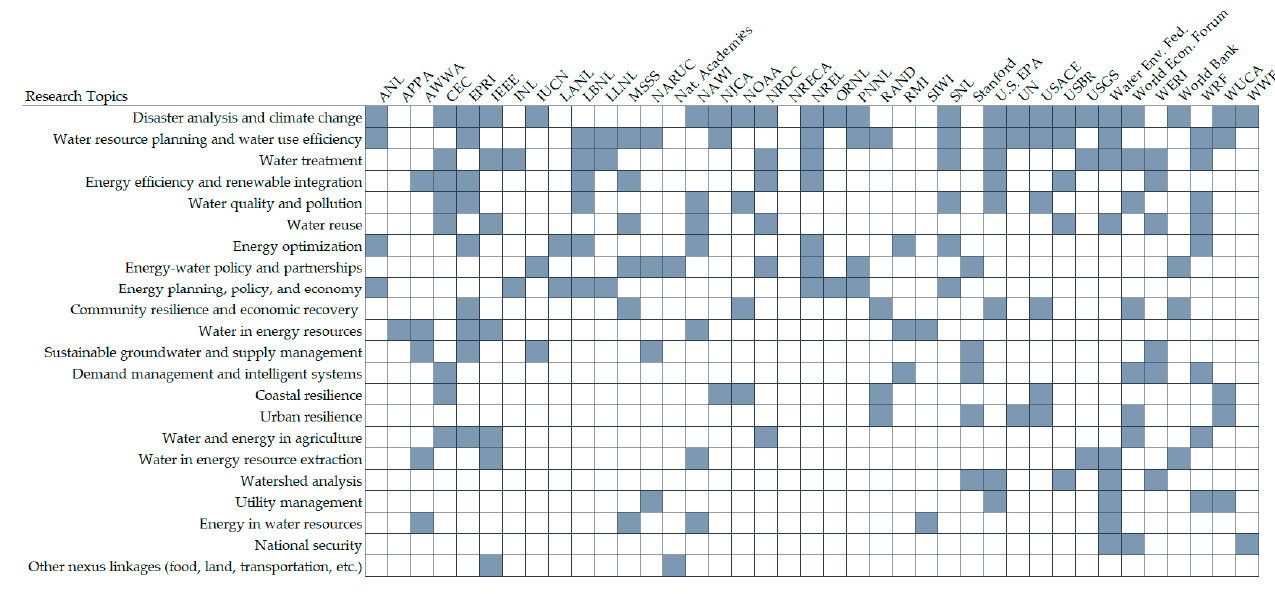
Figure 2. Research topic coverage by institution.